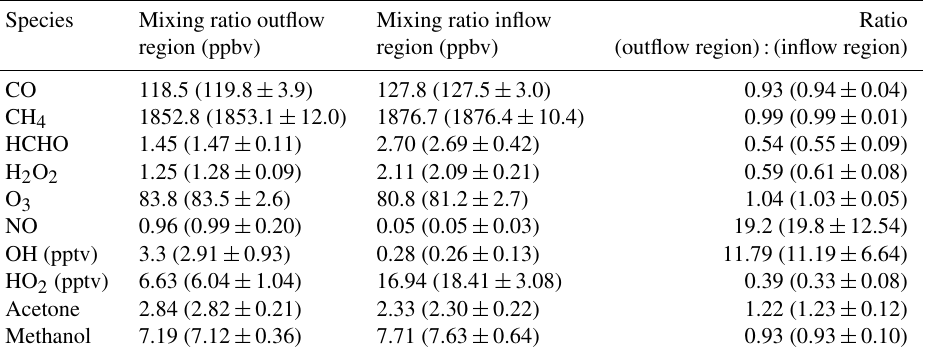
Table 2. Mixing ratios observed in the out- and inflow regions, and their ratios. The median, mean and 1 σ standard deviation of all measure- ments are